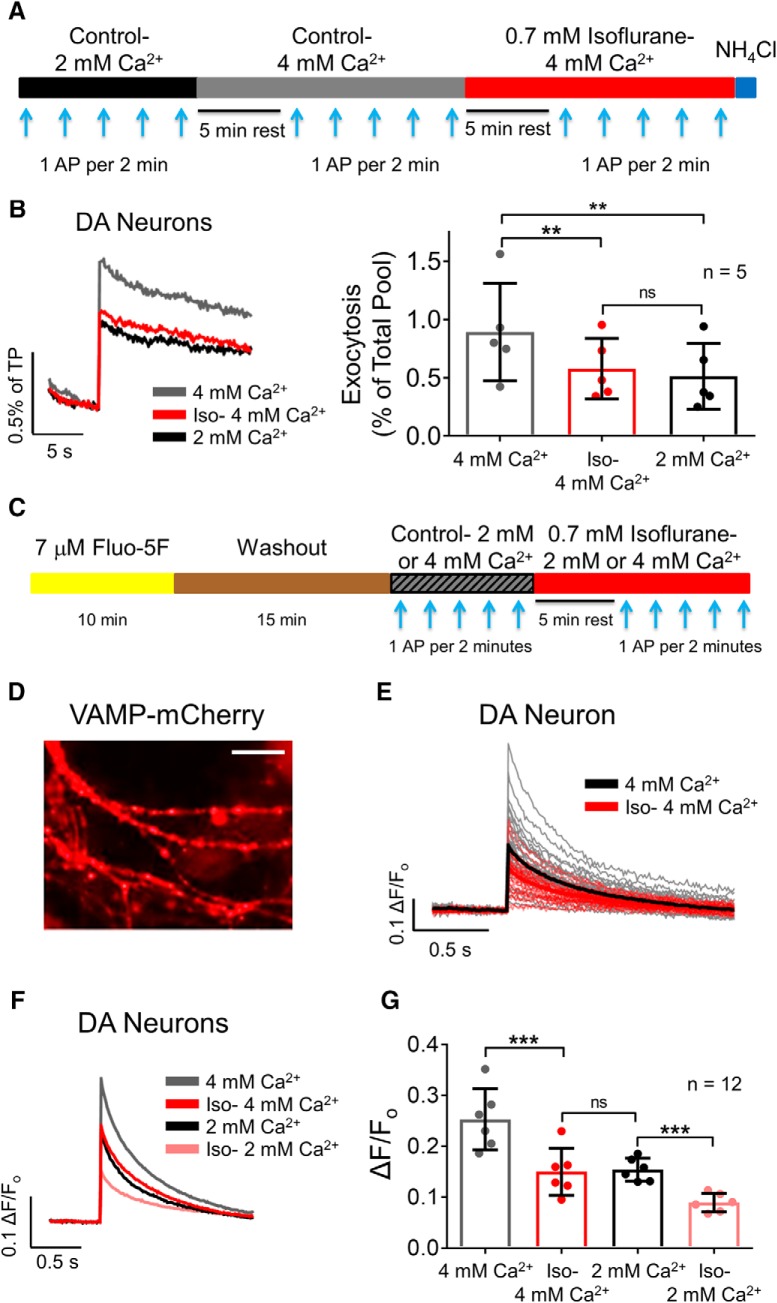
Isoflurane inhibits SV exocytosis in dopaminergic neurons by reducing Ca2+ influx. A, Schematic of single AP (1 AP) evoked exocytosis protocol with 2 mM [Ca2+]e (black bar), 4 mM [Ca2+]e (gray bar), and 2 MAC isoflurane in 4 mM [Ca2+]e (red bar). B, Ensemble average traces and mean values of 1 AP-stimulated exocytosis reported by vMAT2-pHluorin; **p < 0.01; ns, not significant by paired one-way ANOVA, Tukey’s post hoc test. C, Schematic of the Ca2+ influx protocol with Fluo-5F (yellow bar) followed by washout and 1 AP stimulation with 4 mM [Ca2+]e (gray bar), 0.7 mM isoflurane in 4 mM [Ca2+]e (red bar) or 2 mM [Ca2+]e (black bar). D, Fluorescence microscopy image of VAMP-mCherry transfected neuron from which Ca2+ signals were recorded. Scale bar, 5 μm. E, Fluorescence traces from individual boutons of the neuron in panel D with and without isoflurane in 4 mM [Ca2+]e. Mean responses are shown in bold. F, Ensemble average traces. G, Mean values of 1 AP-stimulated Ca2+ influx reported by Fluo-5F in 4 mM [Ca2+]e, isoflurane in 4 mM [Ca2+]e, 2 mM [Ca2+]e, or isoflurane in 2 mM [Ca2+]e(right); ***p < 0.001; ns, not significant by paired one-way ANOVA with Tukey’s post hoc test.